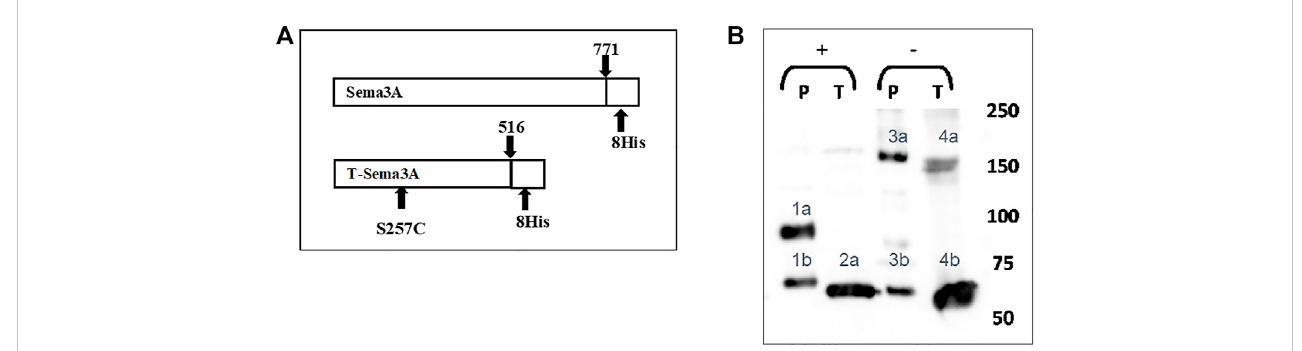
FIGURE 1 Generation of a modi fi ed truncated sema3A (A) . The sequence of truncated sema3A (lower scheme) is a modi fi ed construct of the original/parental sema3A (upper scheme). The new construct truncated at amino acid 516 of the original sema3A with a point mutation at position 257, which exchanged a serine into a cysteine residue (S257C mutation), with 8xHis epitope tags at the C terminal. (B) . The culturing medium of HEK293 cells expressing either P-sema3A or T-sema3A was collected and puri fi ed on a nickel af fi nity column to produce puri fi ed parental (P)-sema3A and truncated (T)-sema3A. The